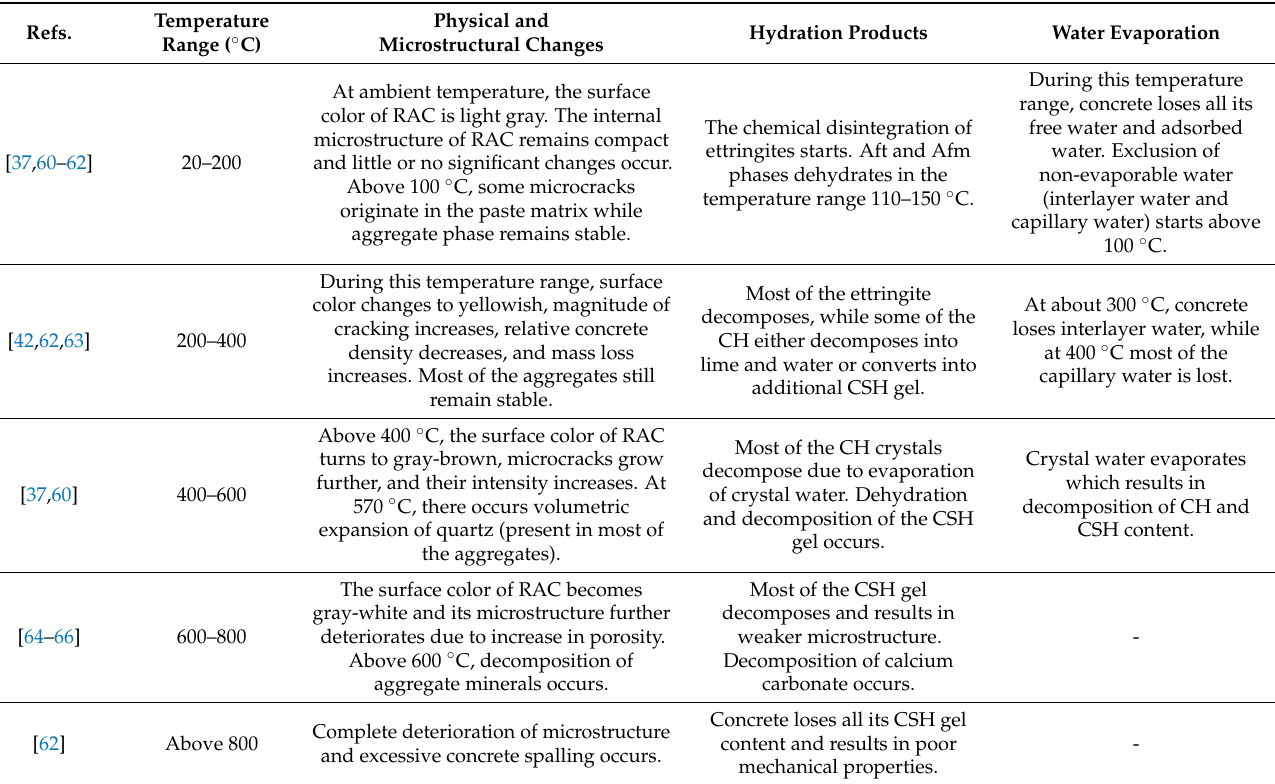
Table 1. Physio-chemical changes in the microstructure of RAC with varying thermal exposure.